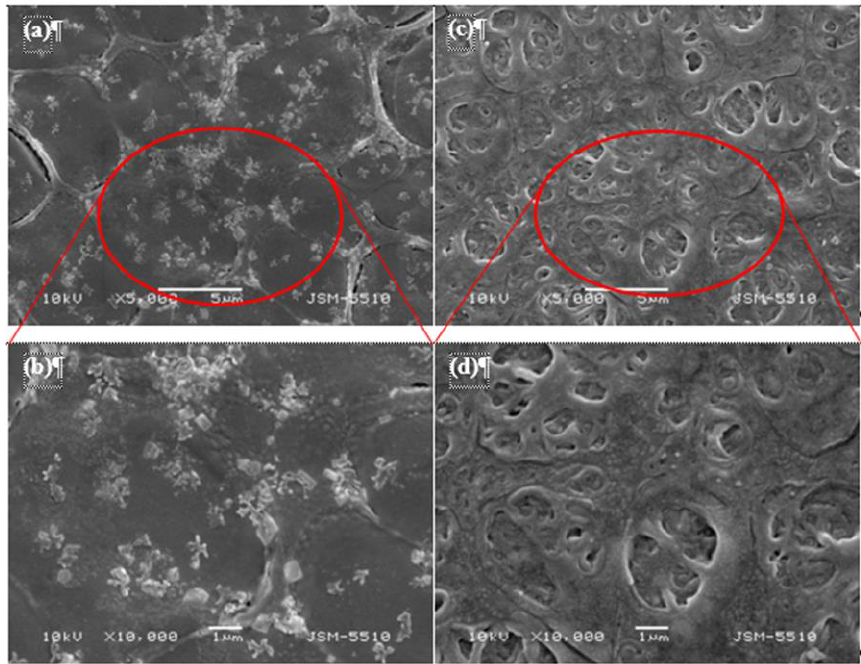
Figure 5. SEM images at different magnifications of ( a , b ) NIIM and ( c , d )